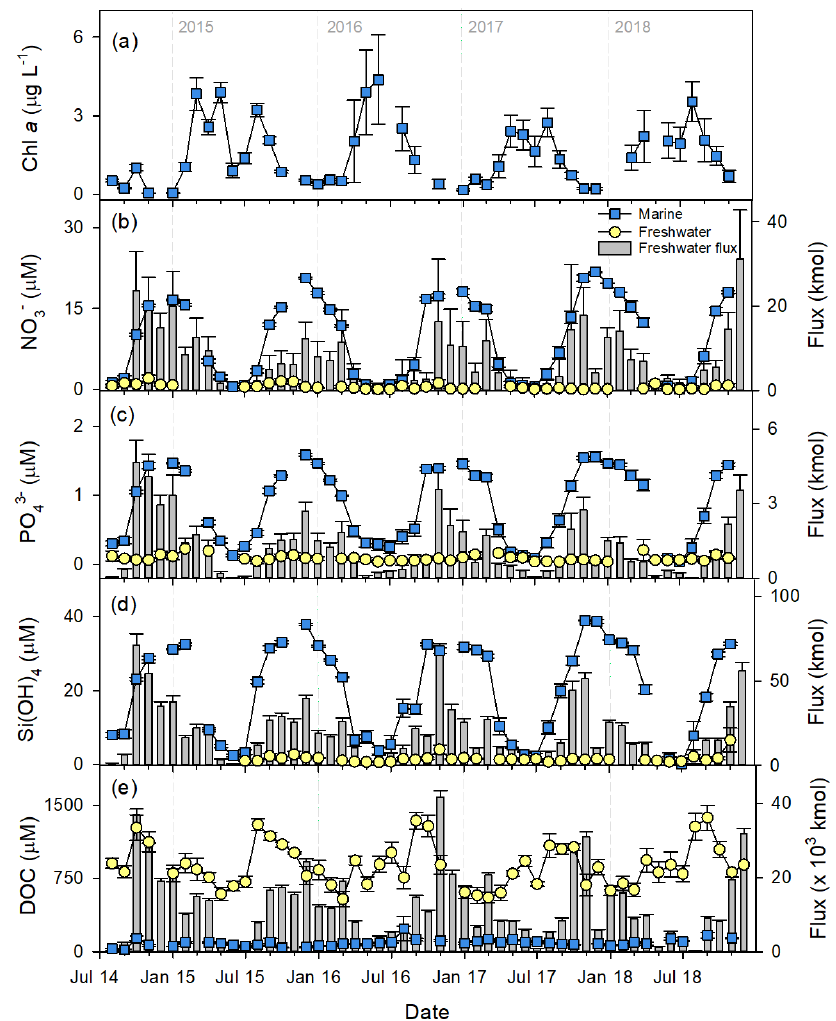
Figure 3. Time series of mean ( ± SE) measured monthly chlorophyll a (a) , nutrient (b–d) , and dissolved organic carbon (e) concentrations across both marine (mean of 0, 1, and 5m depths) and freshwater stations. Freshwater fluxes to nearshore waters are also shown, upscaled from the measured fluxes to the entire drainage area of the Kwakshua Channel system. NO − PO 3 − , orthophosphate; DOC, dissolved organic 4